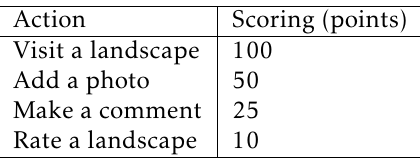
Table 1. Scores awarded to the user actions.